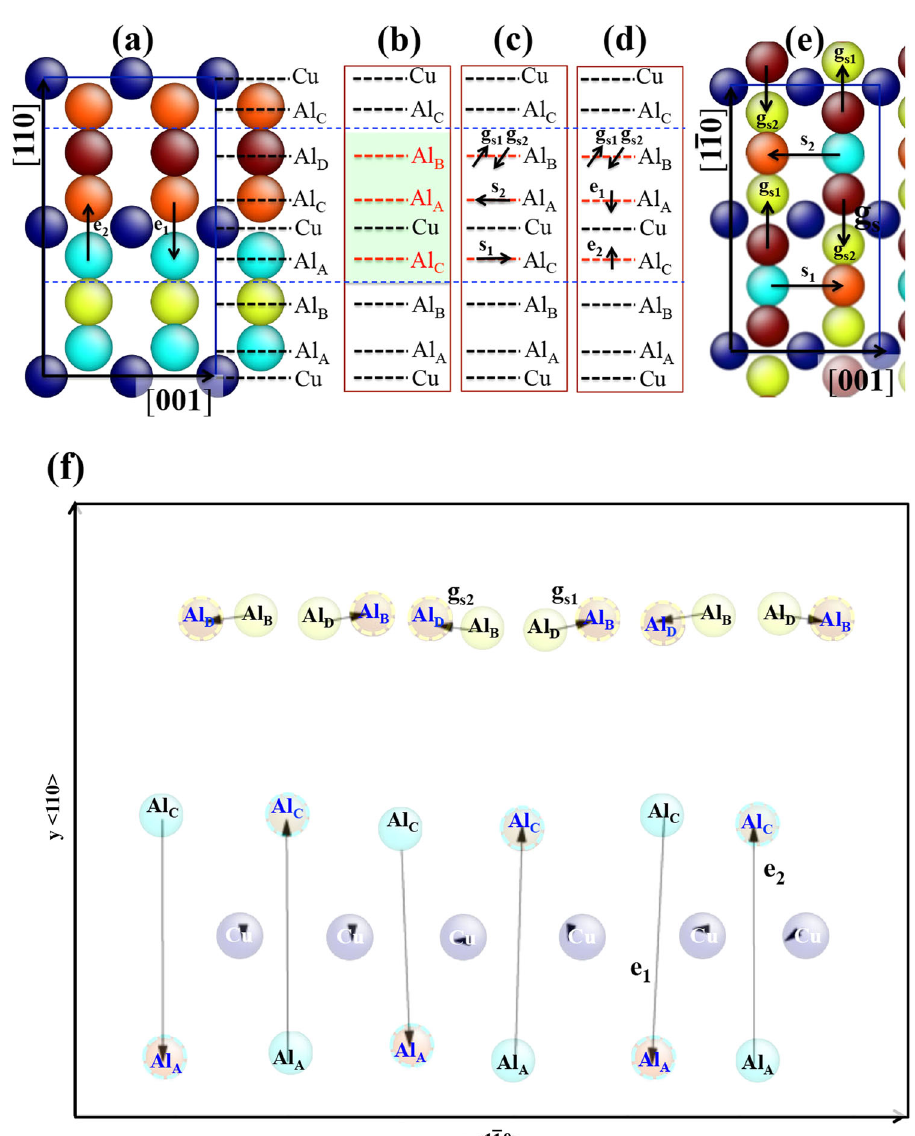
Fig. 6 Collective glide of a vertical-extended dislocation with 4 atomic planes separation. The atomic structures of projection of a unit cell (a) along the < 1 0 > direction, showing the atomic stacking of eight (110) planes in a unit cell: … CuAlAAlBAlACuAlCAlDAlC … and (e) along the < 110 > direction, showing the plan-view of eight (110) planes. (b) The stacking change of four (110) atomic planes associated with collective gliding of two partials on the shear planes (blue dashed lines). (c) and (d) two possible shuf fl e mechanisms. The shuf fl e displacements are indicted in two projected planes (a) (1 0) and (e) (110). (f) Atomic displacements of atoms in one (001) plane, being consistent with shuf fl e mechanism in